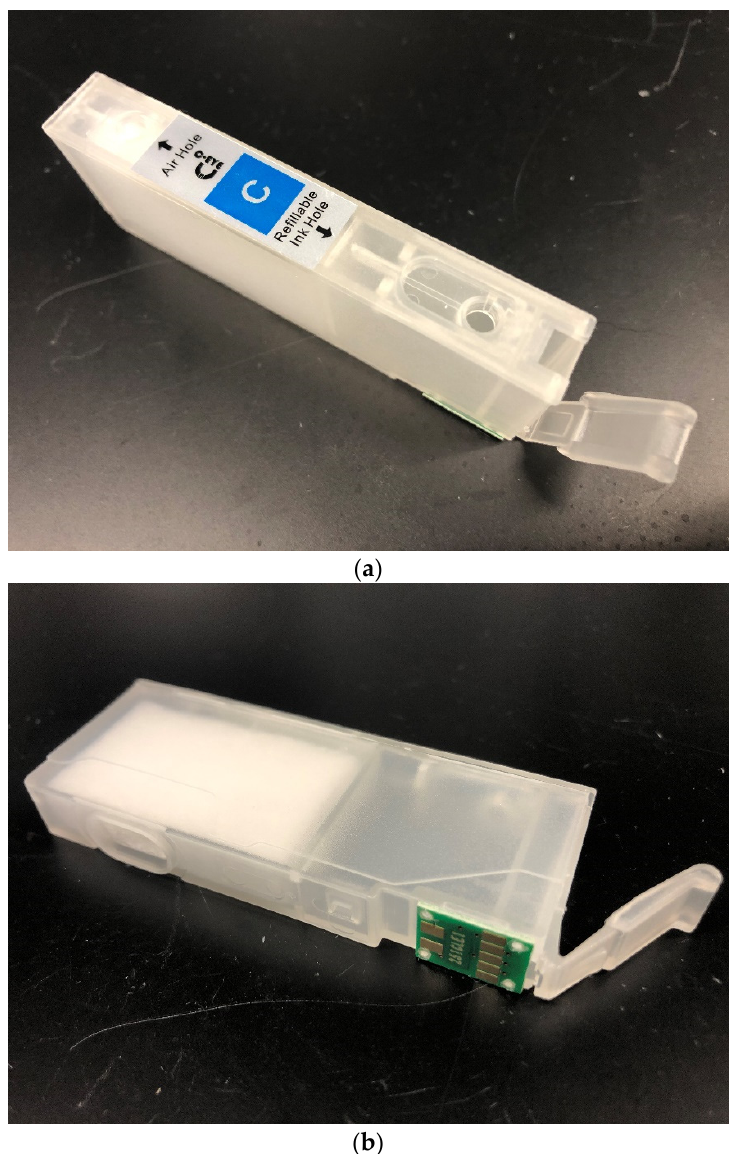
Figure 3. ( a ) Top view of refillable inkjet cartridge displaying the refillable ink hole. ( b ) Side and bottom view of refillable inkjet cartridge showing the internal ink reservoir and dispensing hole.